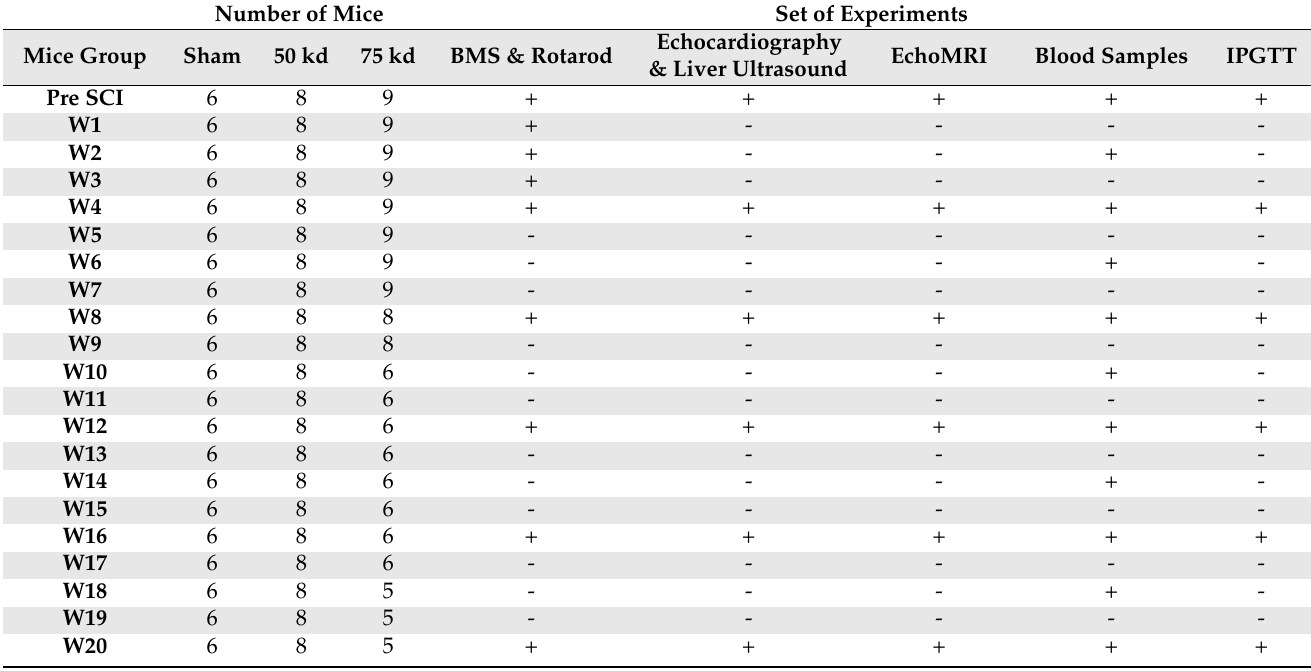
Figure 1. Schematic diagram of the experimental design. Six-month-old male mice were used to measure a baseline for Echo MRI, echocardiography (Echo), liver ultrasound, intraperitoneal glucose tolerance test (IPGTT), and body weight (BW). At day 0, T8 contusion SCI was induced, and the same measurements were performed at 4, 8-, 12-, 16-, and 20-weeks post-injury. IPGTT was performed only at the 12 and 20-week time point. Blood plasma was collected twice monthly. For behavioral assessments, BMS and rotarod tests were performed pre-injury and again at days 2 then week 1, 2, 3, 4, 6, 8, 10, 12, 14, 16, 18, and 20 post-injury. At week 20 post-SCI, animals were sacrificed, blood plasma was collected, and tissues (hearts, livers, and spinal cords) were harvested for histological analyses. Table 1. Summary of number of treatment groups; the experiments were performed up to 20 weeks post SCI.